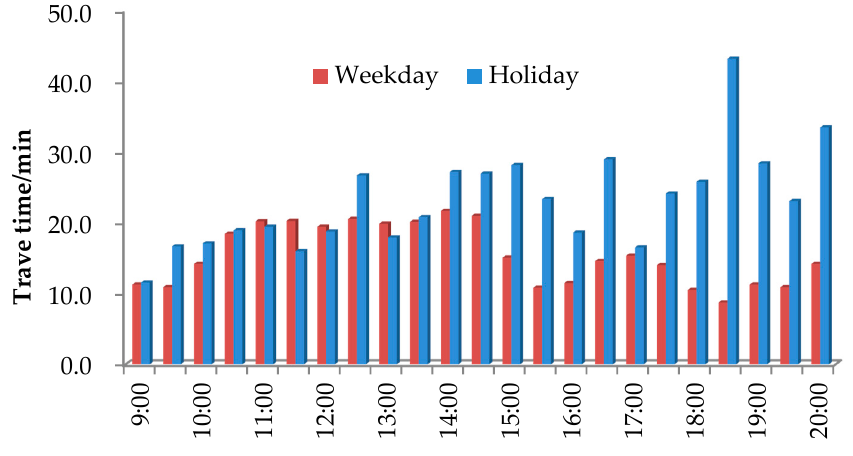
Figure 7. Comparison of weekday and holiday.